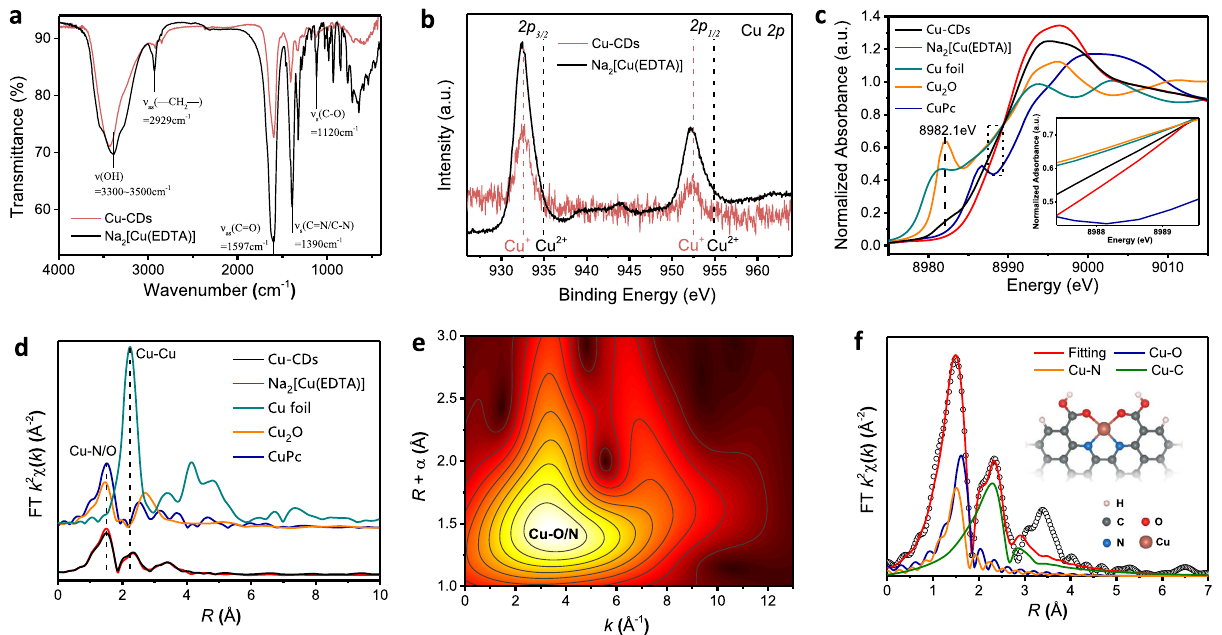
Fig. 2 Surface properties and electronic states studies. a FT-IR spectra and b high-resolution Cu 2p spectra of Cu-CDs and its precursor Na 2 [Cu(EDTA)]. c X-ray absorption near-edge structure (XANES) spectra and d Fourier transform (FT) EXAFS spectra at the Cu K-edge of Cu-CDs, Na 2 [Cu(EDTA)], Cu foil, Cu 2 O, and CuPc sample (inset is the magni fi ed image of dashed box). e Wavelet transform (WT) of Cu-CDs. f EXAFS fi tting curves of Cu-CDs in R space using backscattering paths of Cu – N, Cu – O, and Cu – C. The inset in ( f ) shows the structure of Cu sites in